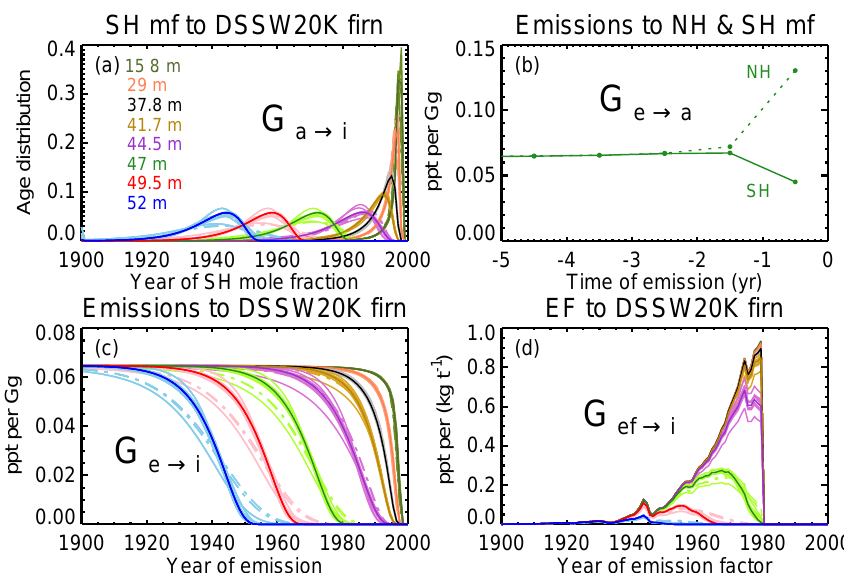
Figure 1. (a) Green’s functions ( G a → i ) relating the mole fraction at DSSW20K measurement depths to high-latitude southern hemispheric (SH) atmospheric mole fraction, from the firn models, with different colours for each depth. The dark coloured lines show the preferred Green’s functions from the CSIRO model, while the lighter coloured lines show the other members of the ensemble of Green’s functions, with the Green’s functions from the LGGE-GIPSA firn model shown with the dot-dashed lines. (b) Green’s functions ( G e → a ) describing the relationship between atmospheric mole fraction inppt in the high-latitude Northern Hemisphere (NH, dashed line) and high-latitude Southern Hemisphere (solid line) and annual global CF 4 emissions in Gg in preceding years, from the AGAGE 12-box model based on the spatial emissions distribution described in the text. We define mole fractions to correspond to the start of the year and emissions to correspond to the middle of the year. The x axis gives the time of emission relative to the time of atmospheric mole fraction. (c) Green’s functions ( G e → i ) relating the mole fraction at DSSW20K measurement depths to annual global CF 4 emissions, derived by combining the Green’s functions in parts (a) and (b) . Line styles and colours are as in (a) . (d) Green’s functions ( G ef → i ) relating the mole fraction at DSSW20K measurement depths to annual global CF 4 emission factor in kgt − 1 , derived by combining the Green’s functions in part (c) with annual global primary aluminium production up to 1980. Line styles and colours are as in (a)